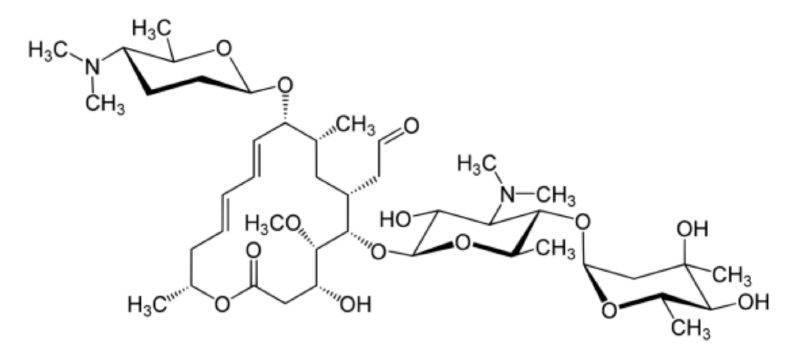
Figure 1. The structure of